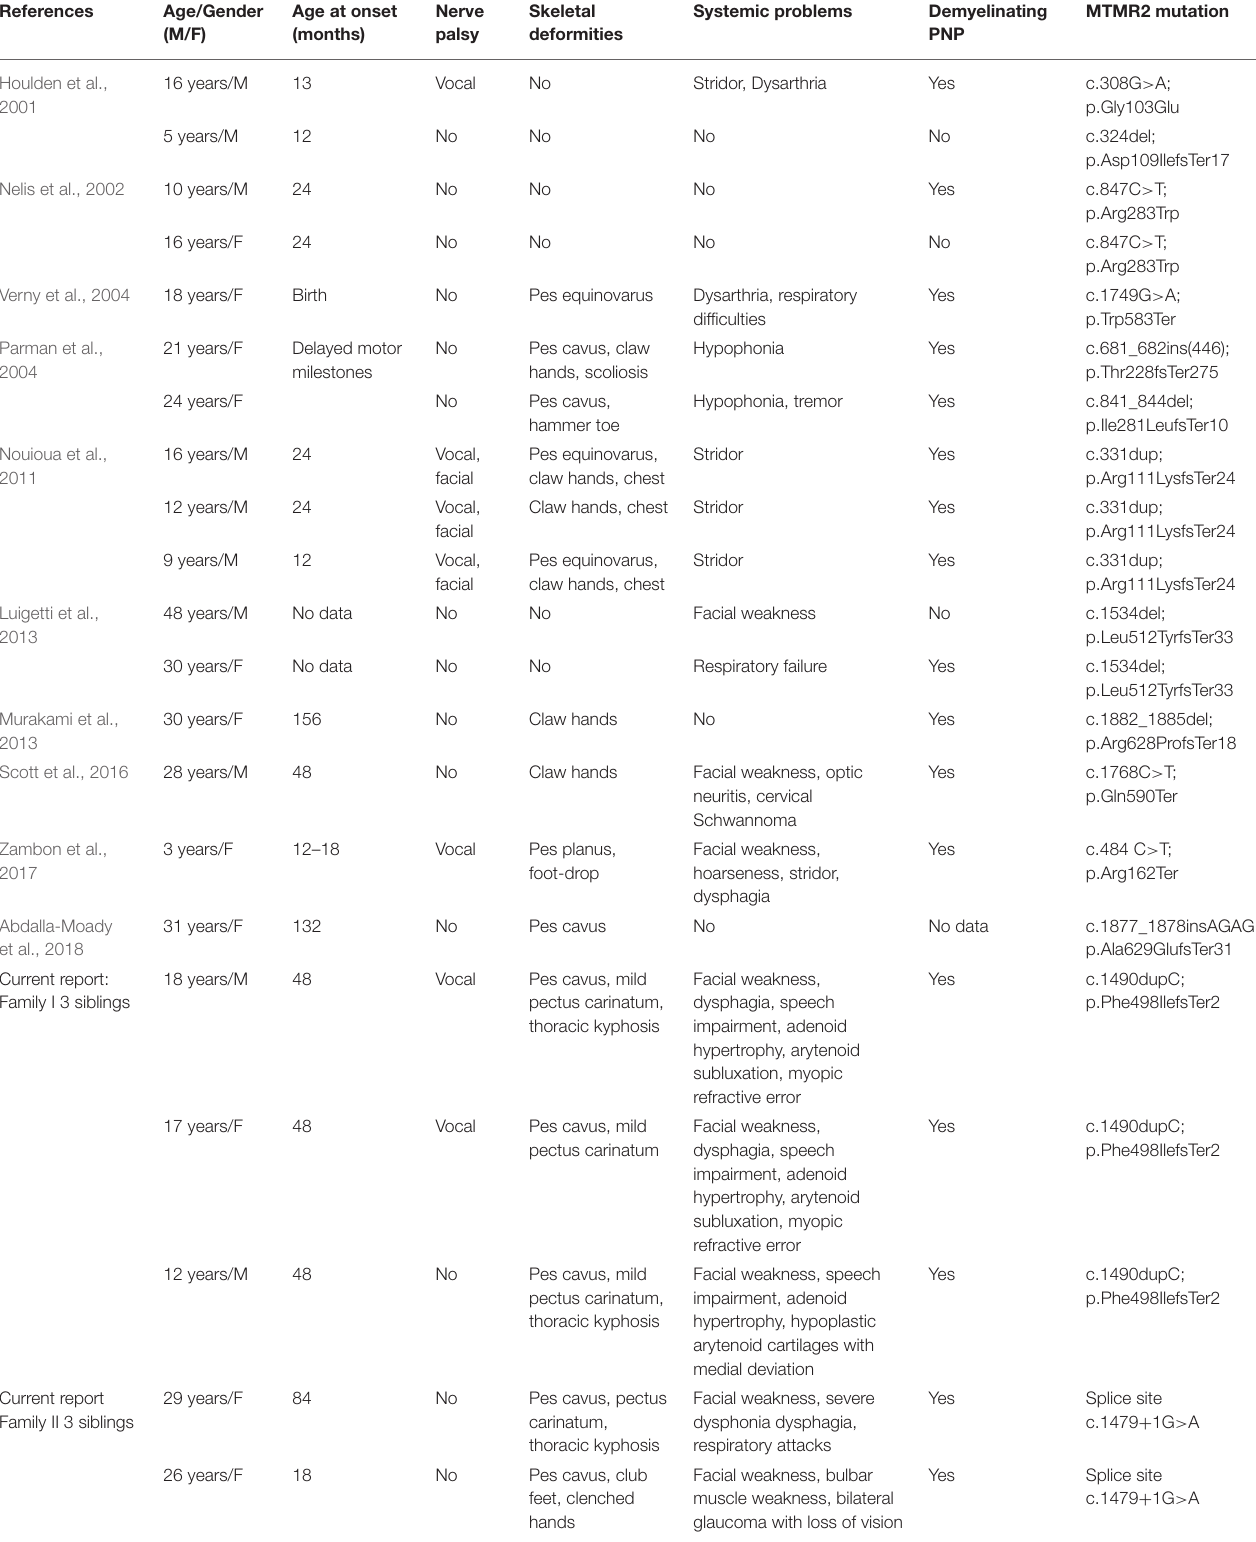
TABLE 2 | Overview of MTMR2 related Charcot-Marie-Tooth disease type